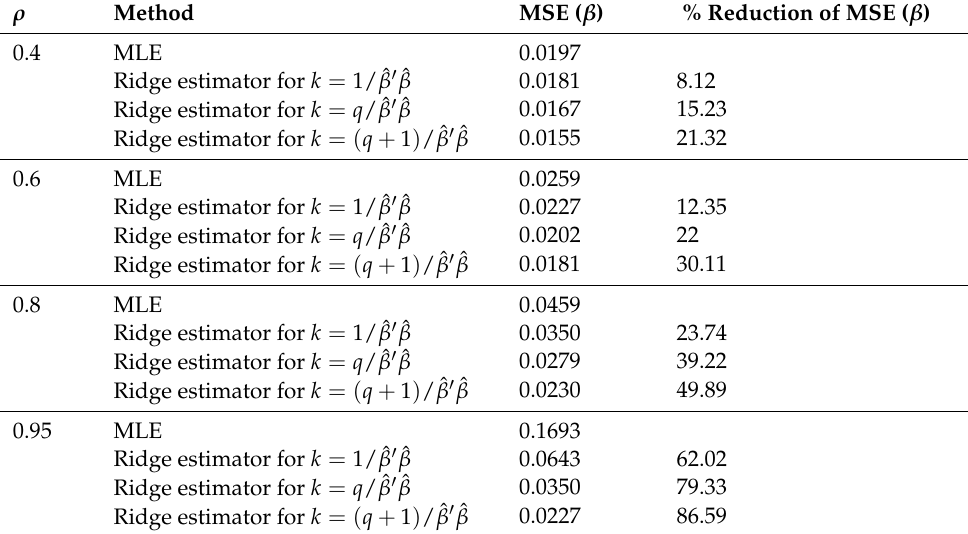
Table 2. Comparison of MSE between the MLE and ridge estimators in simulation; n = 200.